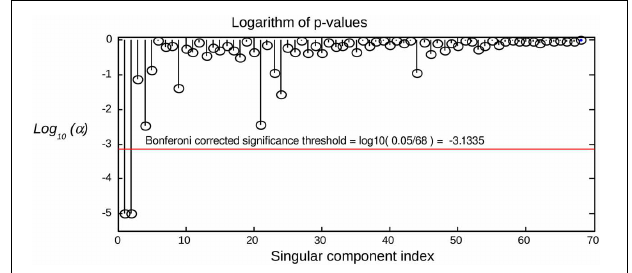
FIGURE 2 | Raw components’ log ( p ) -values computed using the suggested randomization scheme. The horizontal line corresponds to Bonferroni corrected threshold determined for α = 0 . 05. The data were simulated with two dipolar sources and powerful spatially coherent interference. SVD was applied to the stimulus-locked data matrix that yielded first singular topographies. Subspace correlation of the first two singular topographies with the true signal subspace was [1,0.987]. We can see that the suggested randomization scheme is able to correctly detect the first two components that span the signal